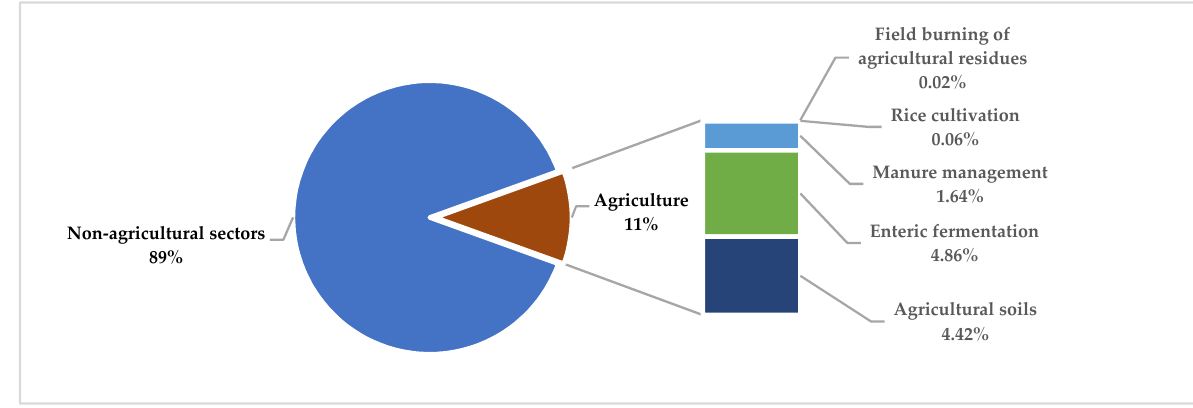
Figure 2. Sources of greenhouse gas emissions in the EU-28, 2019. Source: European Environment Agency and Eurostat. Table 1. Share of GHG from agriculture* of a given country in the total GHG from EU agriculture and in the total GHG in a given country, 2019 (%).